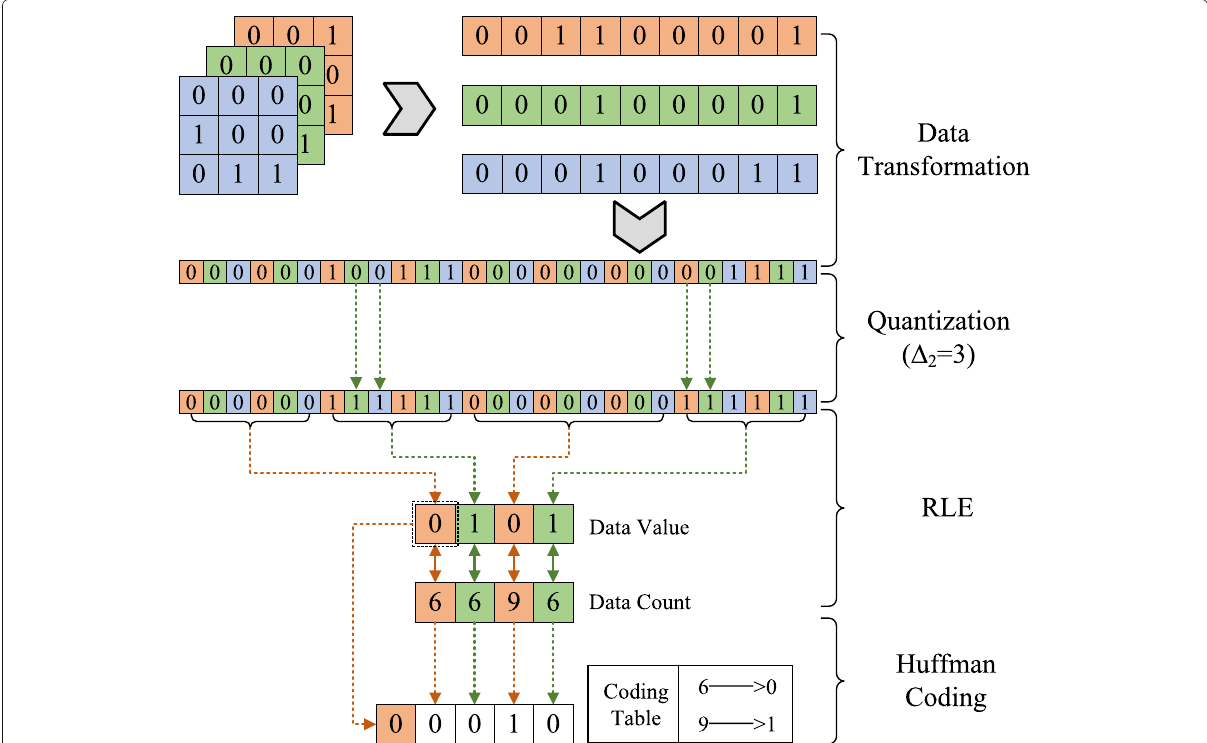
Fig. 5 An example of side information compression. We splice the first element of the data value sequence with the encoded data count sequence to generate the compressed side